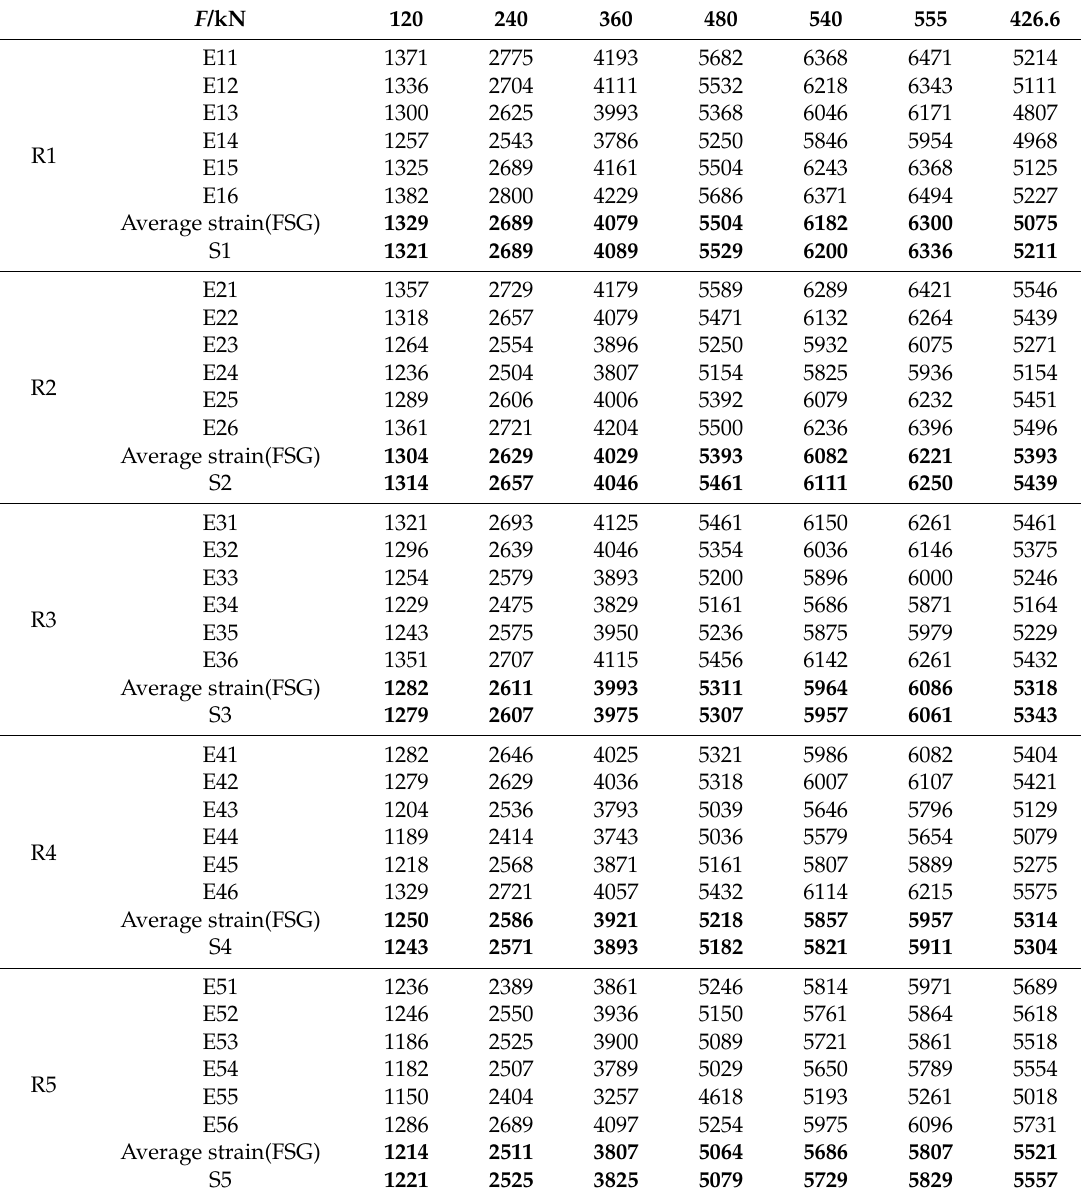
Table 7. The monitored strains of the strand at Step I. (Unit: µε